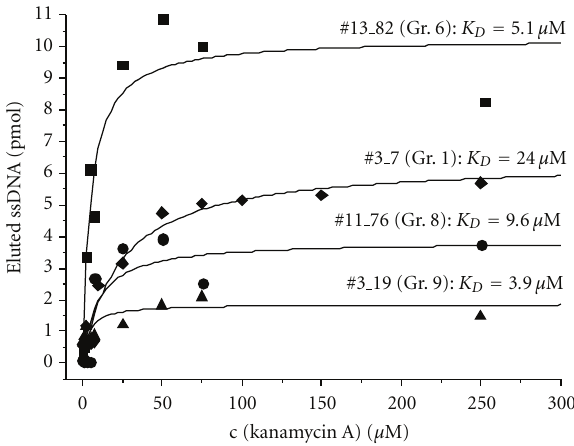
Figure 6: A ffi nity tests on the representatives of aptamer groups evolved from Capture-SELEX. A ffi nity tests were performed similar to the Capture-SELEX procedure, and ssDNA was eluted by di ff erent concentrations of kanamycin A in selection bu ff er. Data was fitted by the model of one site direct binding using a rectan- gular hyperbola for the saturation curve (OriginLab Corporation, OriginPro 8G